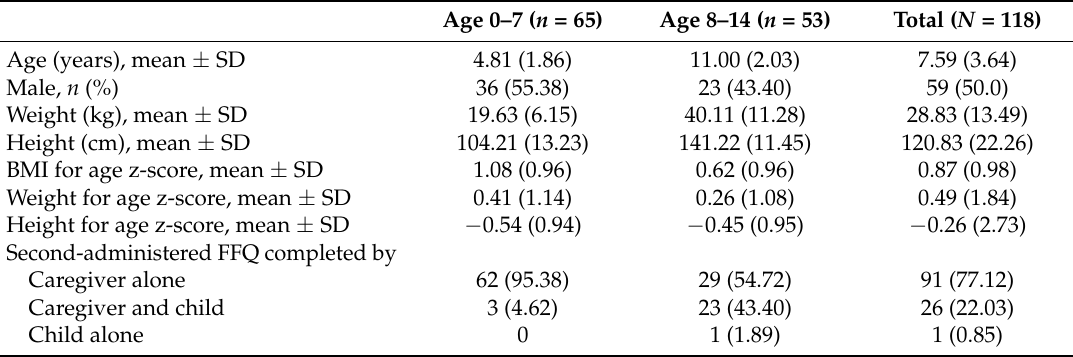
Table 1. Characteristics of study participants at second-administered food frequency questionnaires (FFQ) ( N =